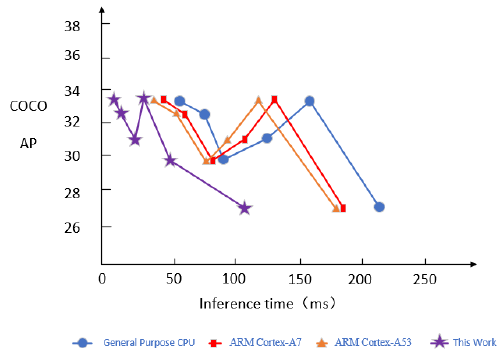
Figure 12. Line graph of the acceleration effect on multiple accelerators among target detection al- gorithms.